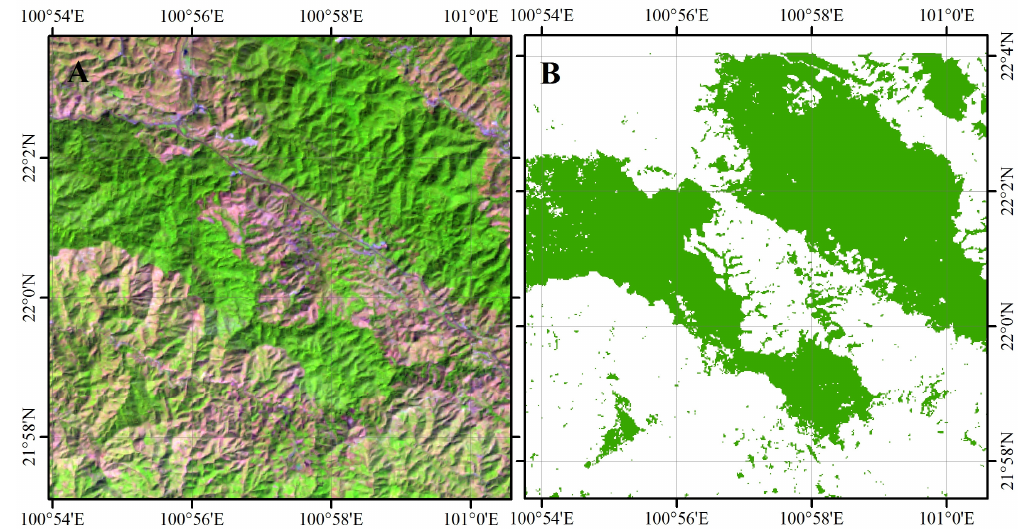
Figure 6. The resultant map is compared with the 30-m Landsat 5 Thematic Mapper (TM) image on the Julian Date 45 in 2010. The evergreen forest shows as green on the composite Landsat 5 TM image ( A ) combined as false color (bands 5/4/3); and ( B ) is the 30-m Landsat-based resultant map of tropical evergreen forests in the study area in 2010.